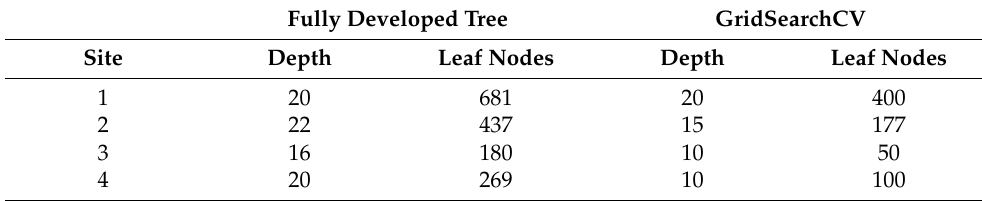
Table 10. Complexity of fully developed trees compared to those obtained through